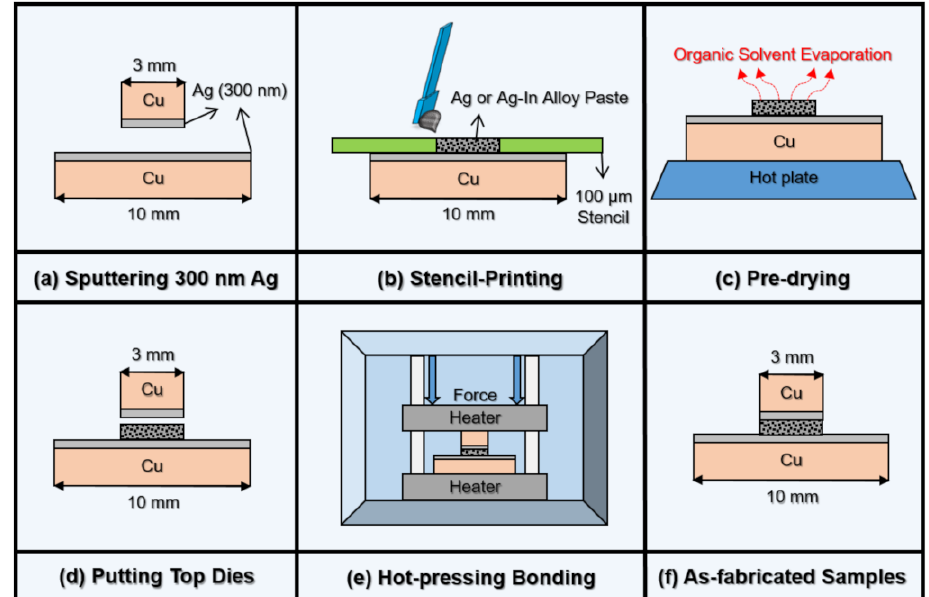
Figure 2. Flowchart of the sintered Ag and Ag–In alloy joint bonding processes. ( a ) Sputtering alloy pastes in thickness on lower substrates, ( c ) pre-drying the pastes on a hot plate, ( d ) placing top dies on the pastes, ( e ) putting the assembly samples in a hot-pressing machine for the bonding process, and ( f ) obtaining as-fabricated samples after the bonding